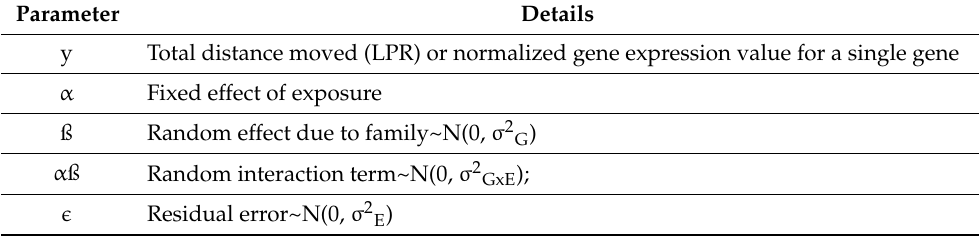
Table 1. Explanation of parameters fit in LMM.